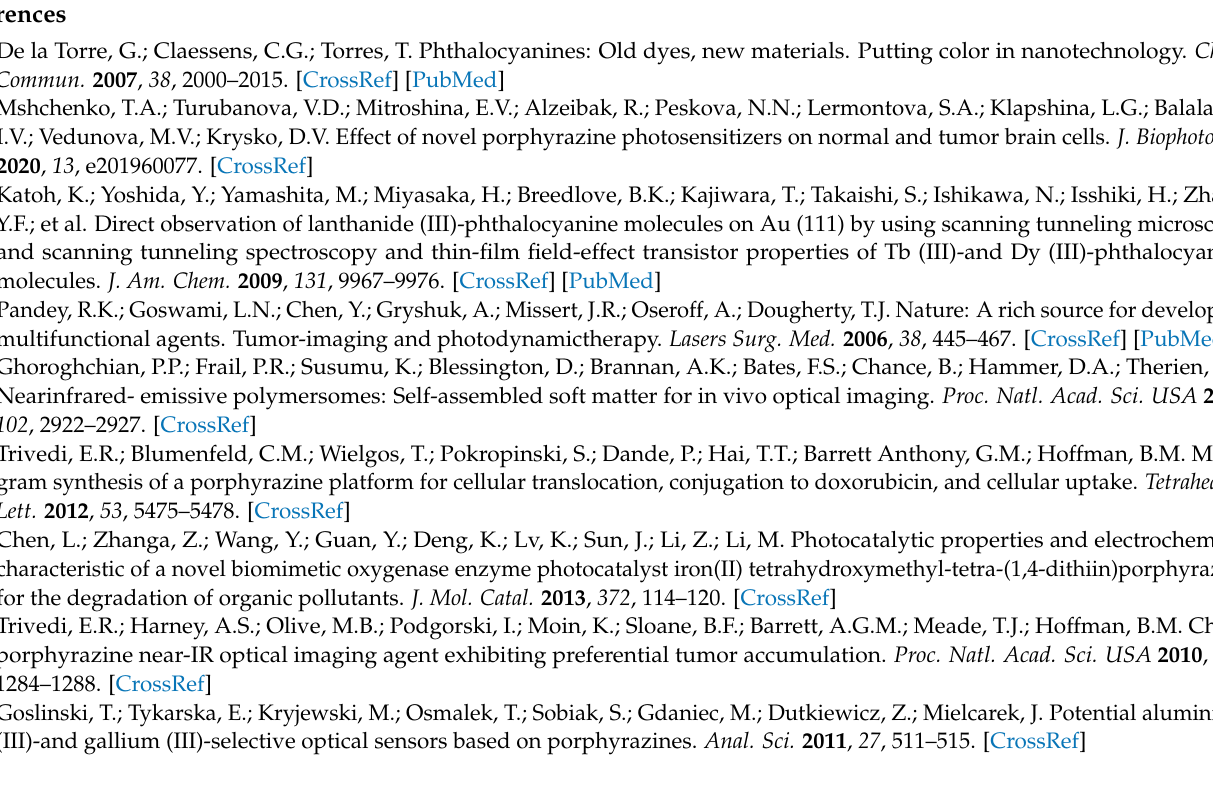
Figure S3: 1 H NMR spectrum of Mg(II)-octa-(2,6-difluorophenyl)tetraazaporphyrin in d 6 DMSO; Figure S4: 1 H NMR spectrum of Zn(II)-octa-(2,6-difluorophenyl)tetraazaporphyrin in d 6 DMSO; Figure S5: IR spectrum of Mg(II)-octa-(2,6-difluorophenyl)tetraazaporphyrin in tablets KBr; Figure S6: IR spectrum of Zn(II)-octa-(2,6-difluorophenyl)tetraazaporphyrin in tablets KBr; Figure S7: 1 H NMR spectrum of di-(2,6-difluorophenyl)maleindinitrile in CDCl 3 ; Figure S8: Mass-spectrum of di-(2,6-difluorophenyl)maleindinitrile; Figure S9: Predicted UV-Vis spectrum of Mg(II)-octa-(2,6- difluorophenyl)tetraazaporphyrin with nstate = 10 и root = 1 parameters; Figure S10: Predicted UV-Vis spectrum of Zn(II)-octa-(2,6-difluorophenyl)tetraazaporphyrin with nstate = 10 и root = 1 pa- rameters; Figure S11: Predicted UV-Vis spectrum of Zn(II)-octa-(2,6-difluorophenyl)tetraazaporphyrin with nstate = 6 и root = 20 parameters; Figure S12: Visualization of the planarity measure of Mg(II)- octa-(2,6-difluorophenyl)tetraazaporphyrin and Zn(II)-octa-(2,6-difluorophenyl)tetraazaporphyrin; Table S1: The values from visualization of the planarity measure and equations of